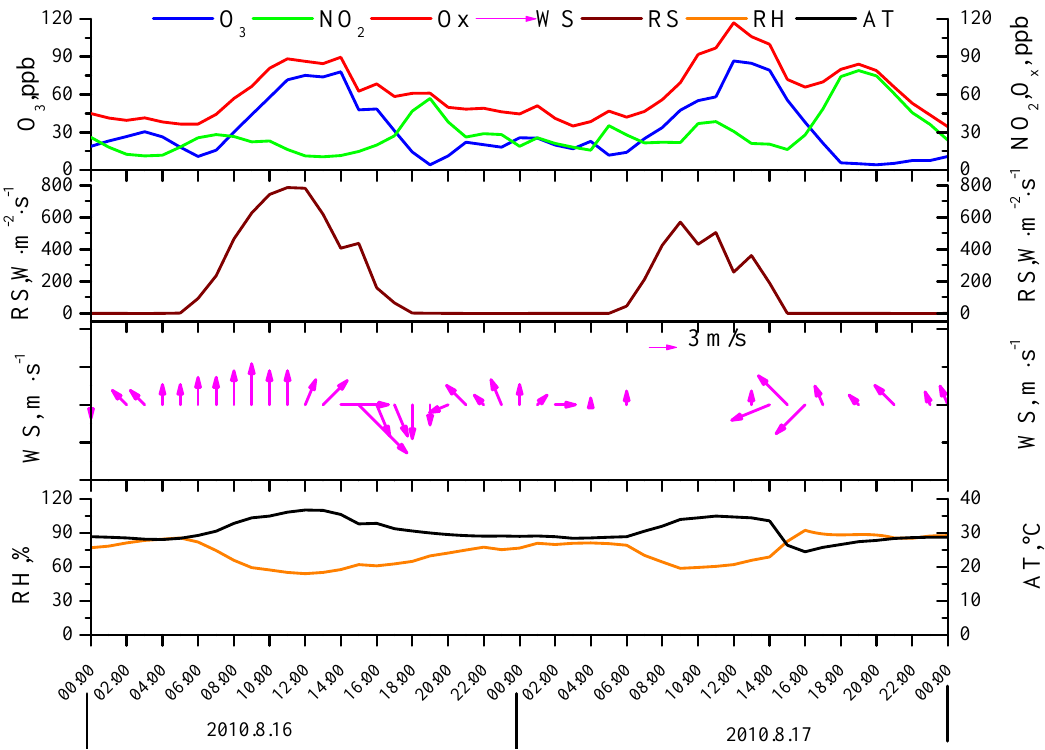
Fig.16. Time series of meteorological conditions and mass concentrations that observed at SAES monitoring site during the high O 3 pollution episode during 16–17 August 2010. (RS: solar radiation intensity; WS: wind speed; AT: air temperature; RH: relative